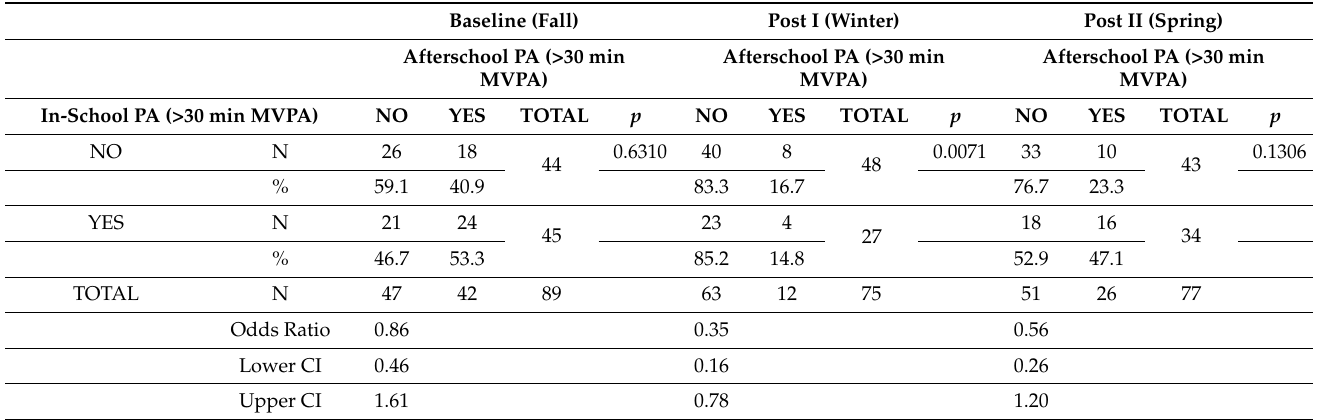
Table 4. Distribution of moderate- to vigorous-intensity physical activity during the in-school and afterschool